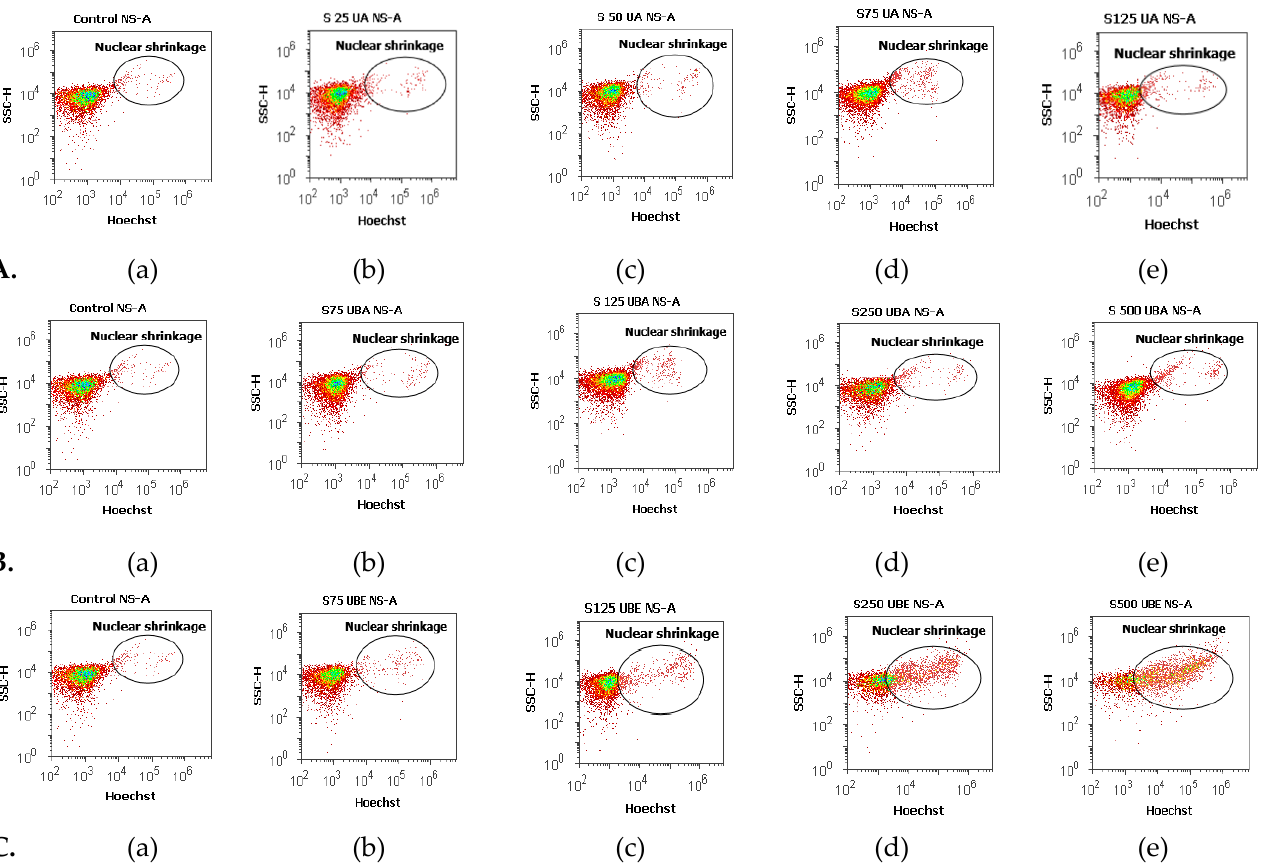
Figure 6. Nuclear shrinkage status of UA, UBA, and UBE treatments in normal blood cell cultures. Hoechst patterns of UA 25, 50, 75, 125 μ g/mL A ( b – e ); B ( b – e ) UBA 75, 125, 250, 500 μ g/mL; C ( b – e ) UBE 75, 125, 250, 500 μ g/mL reported to 1% DMSO ( A ( a ), B ( a ), C ( a )).